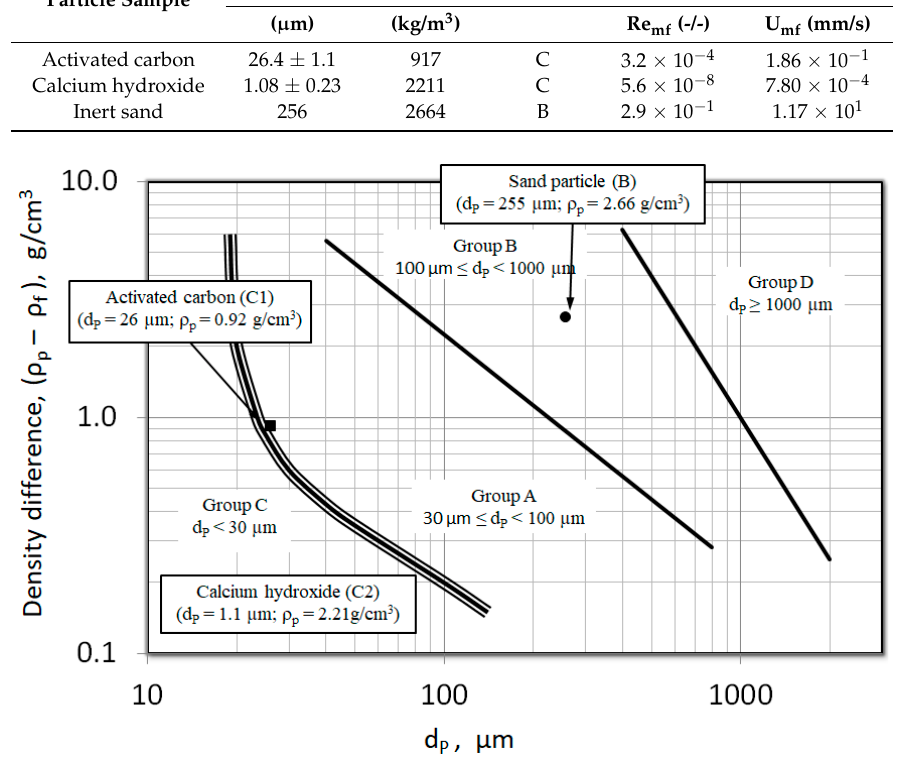
Figure 6. Particle mixing strategy based on the Geldart classification.